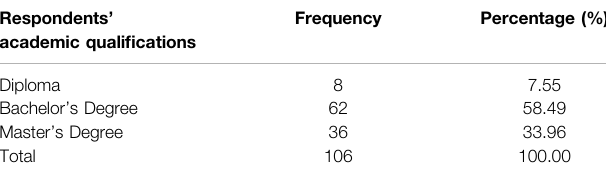
TABLE 5 | Respondents ’ academic quali fi cations.